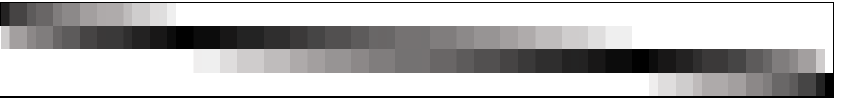
Figure 3. Graphical representation of the probability mass distribution of the Weighted Diagonal algorithm as a heat map, where a probability of one gives black values and zero white values.